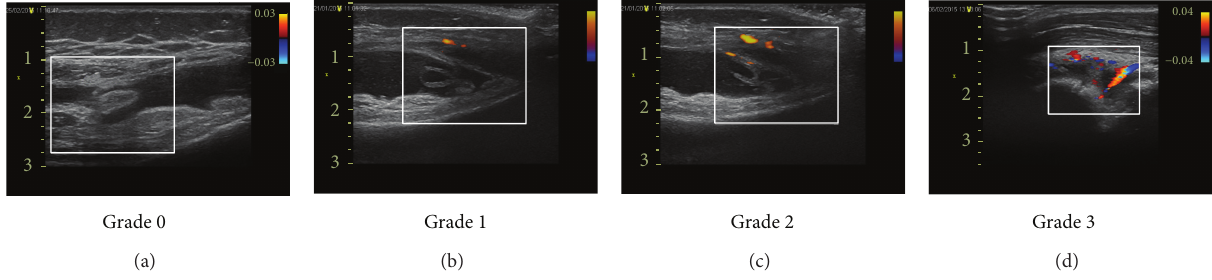
Figure 1: Ultrasound evaluation of joint vascularization scale using Power-Doppler Ultrasonography imaging. Examples of visualization of different degrees of joints inflammation and angiogenesis. Joint vascularization scale: grade 0 = no signs of vascularization, 1 = mild (presence of single/vessel dots), 2 = moderate (presence of confluent vessel dots in less than half of the synovial area), and 3 = marked (presence of confluent vessel dots in more than half of the synovial area).